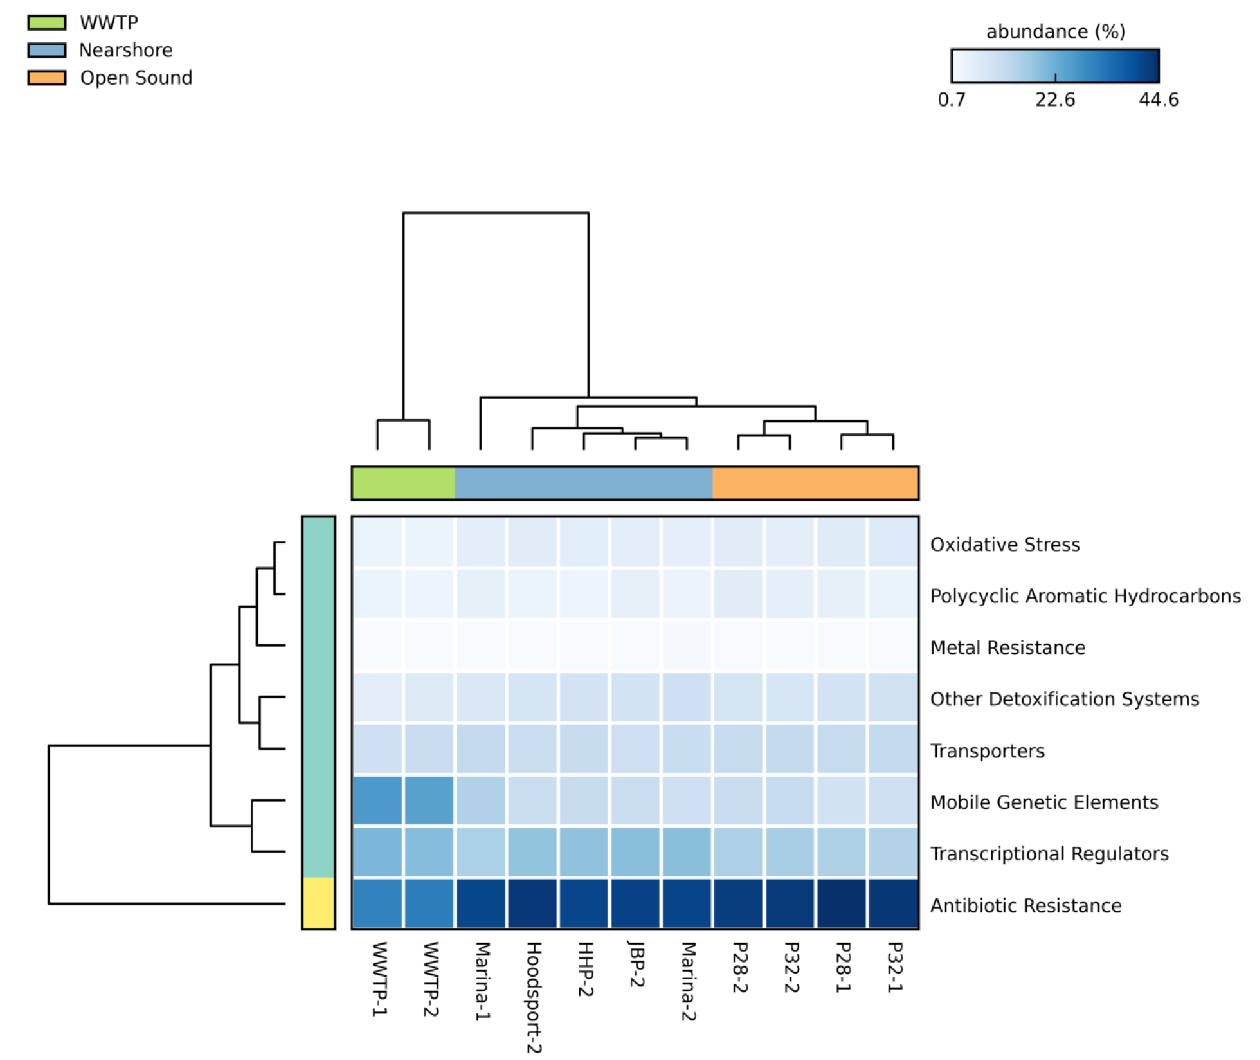
Fig 8. Antibiotic resistance determinant elements, PAH and detoxification system hidden Markov model elements cluster by season and location. Increasing taxonomic abundance is indicated by darker blue boxes. The horizontal color bar at the top reflects sample collection location (wastewater treatment plant (top green), nearshore (top blue) and open sound (top